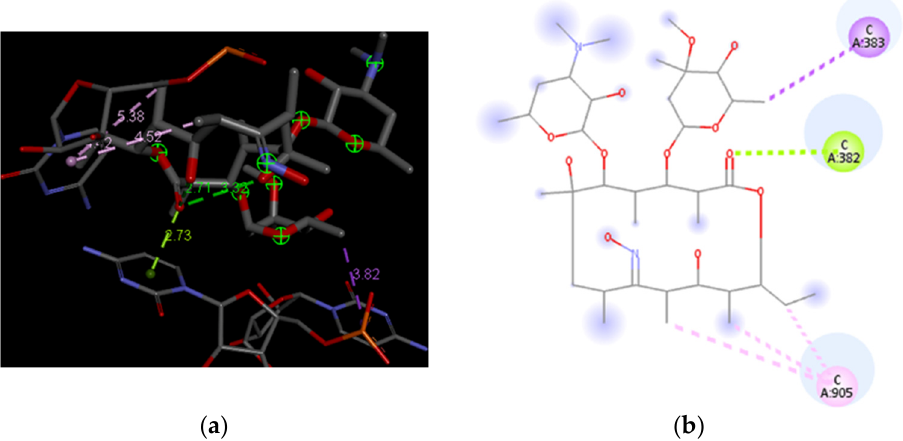
Figure 3 . ( a ) Graphical representation of the obtained interactions between erythromycin B 9-oxime and the segment of the exit tunnel from apicoplast ribosome of P. falciparum with distances in Å; ( b ) 2D diagram of receptor–ligand interactions.